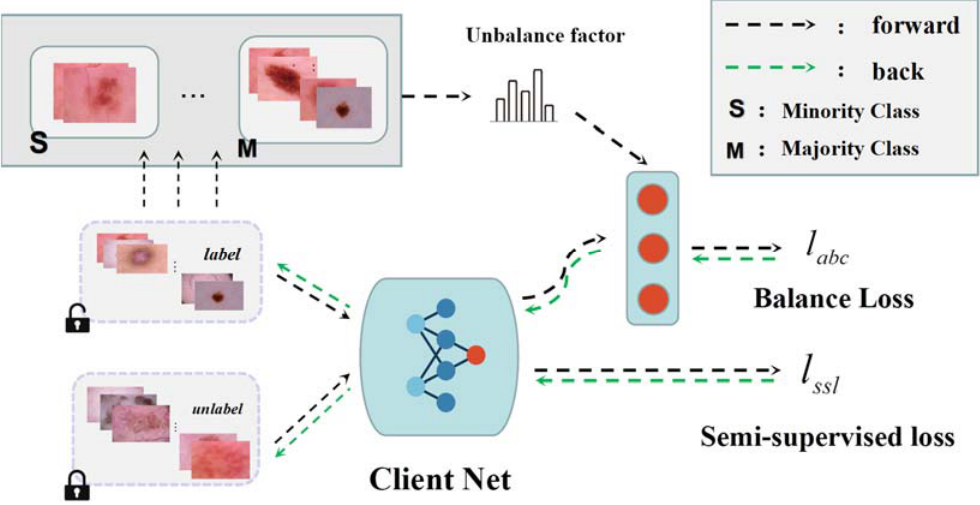
Figure 4. The training method in the local client network and the composition of the class-balanced auxiliary.